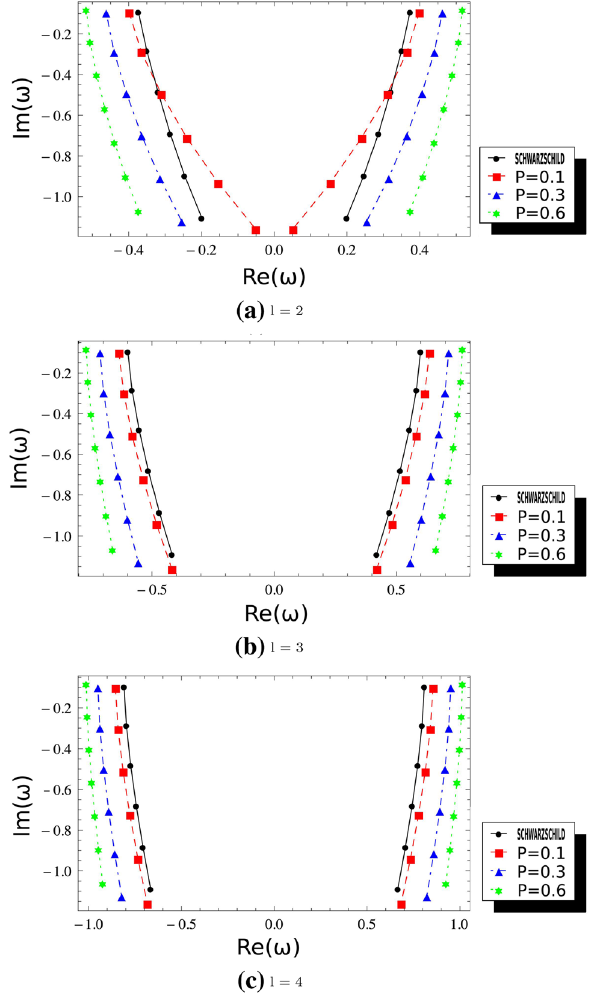
Fig. 7 Imaginary × Real part of ω for a l = 2, b l = 3, c l = 4 and P = 0 . 1, P = 0 . 3, P = 0 .